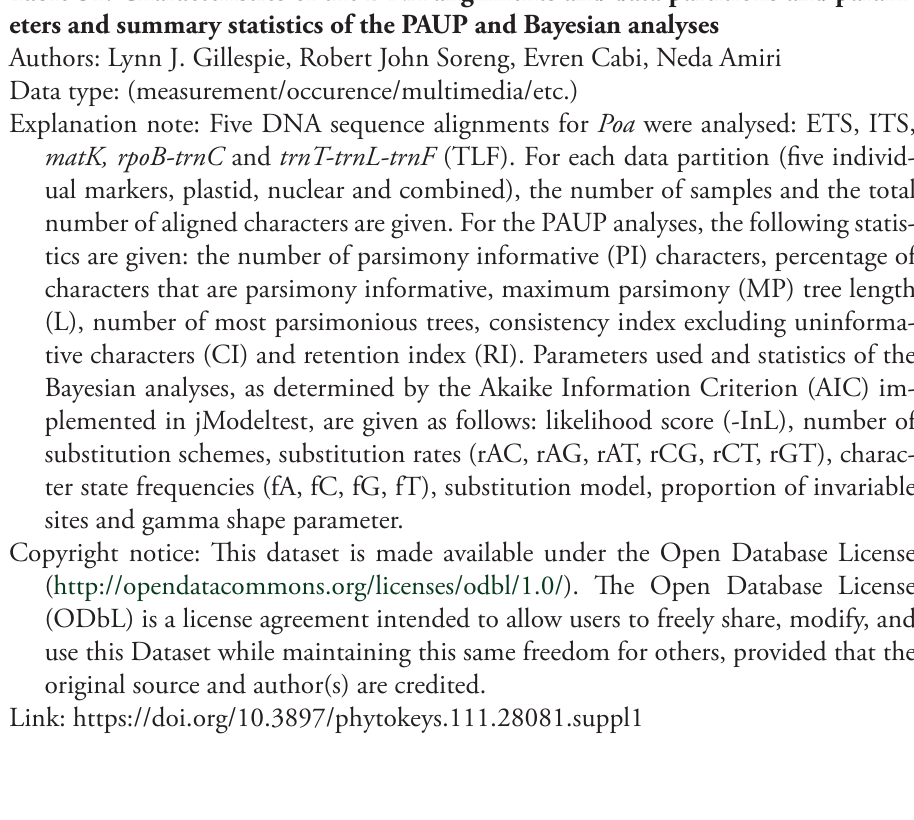
Table S1. Characteristics of the DNA alignments and data partitions and param- eters and summary statistics of the PAUP and Bayesian